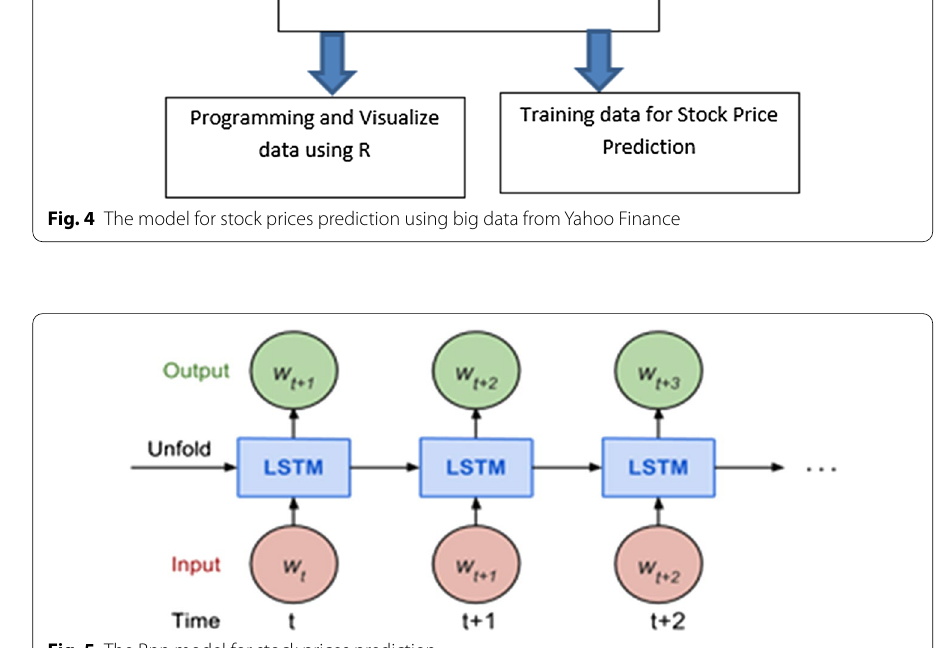
Fig. 5 The Rnn model for stock prices